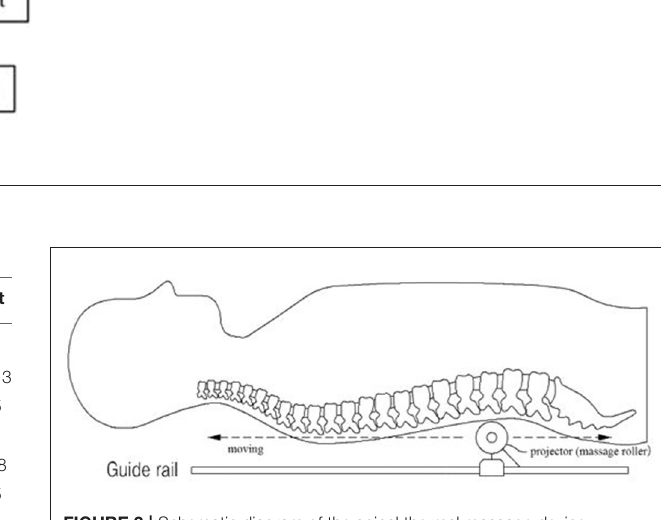
FIGURE 2 | Schematic diagram of the spinal thermal massage